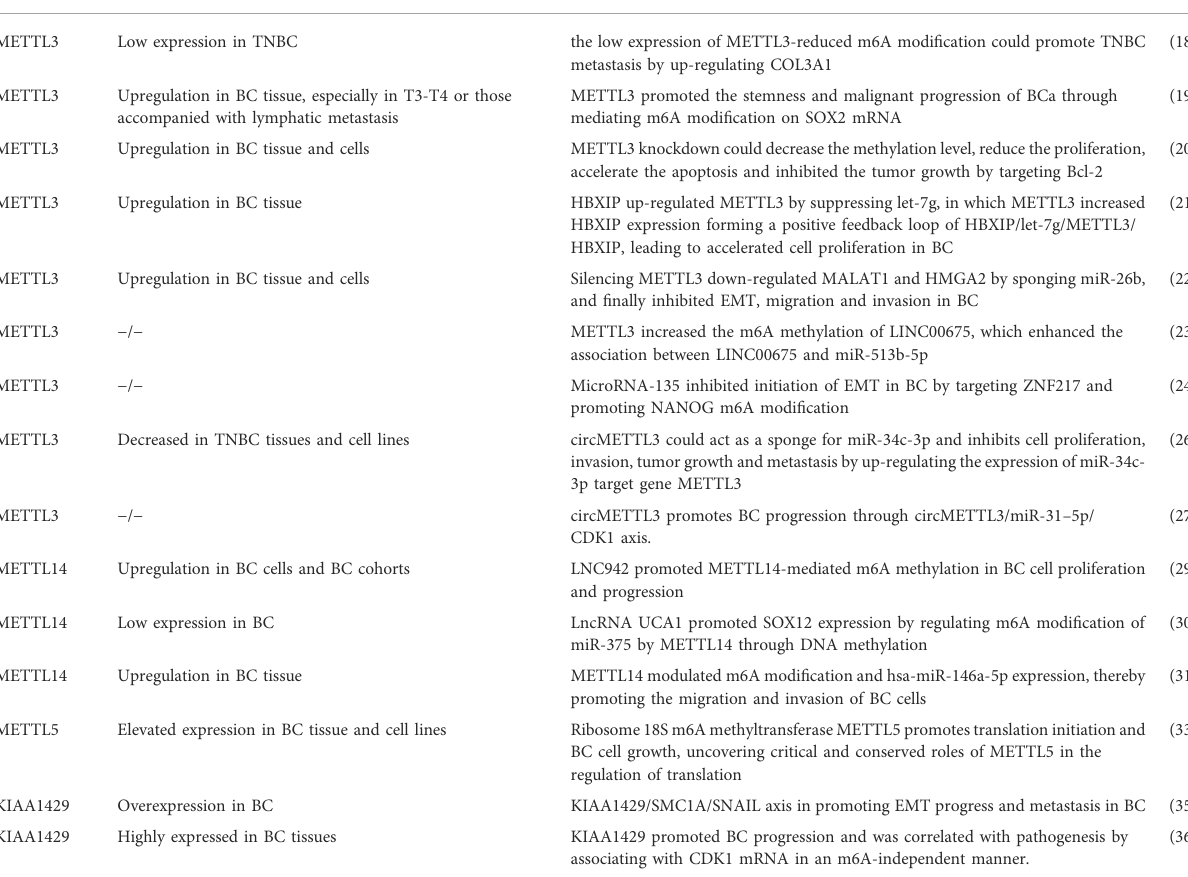
TABLE 1 The mechanisms of m6A writer in regulating BC